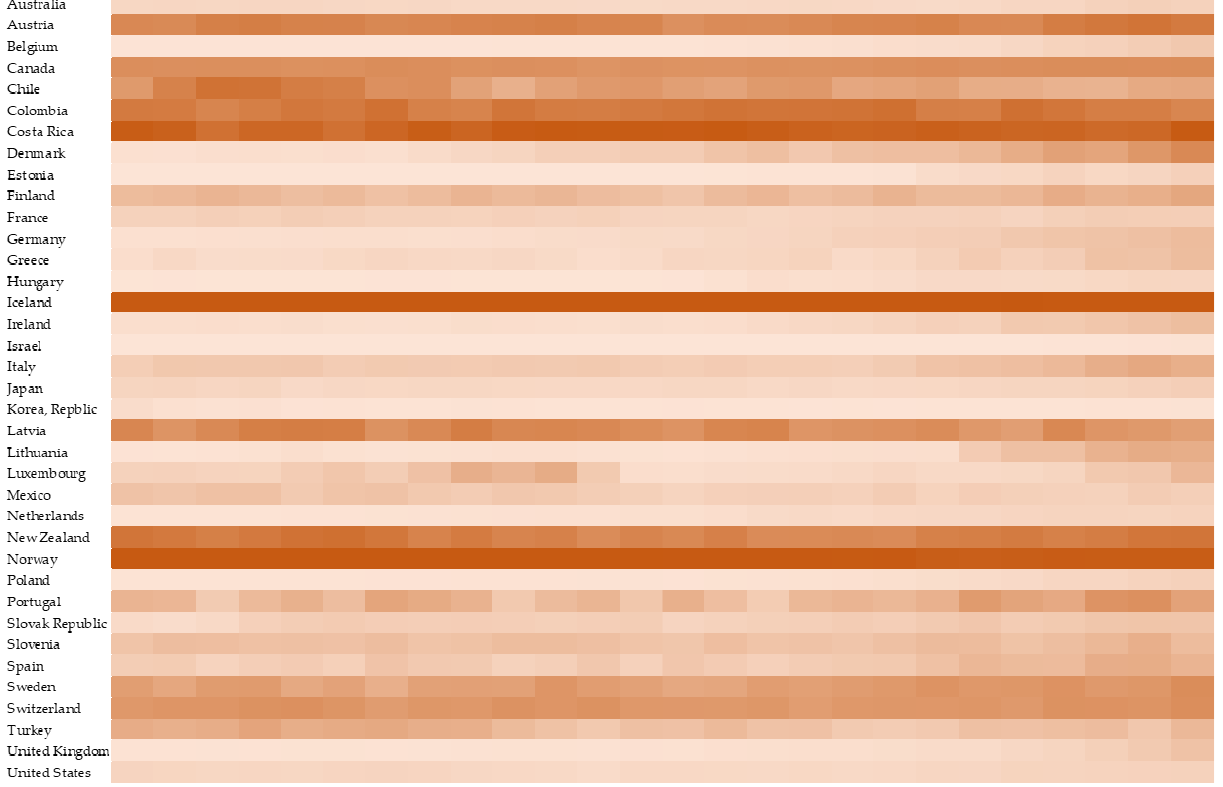
Figure 2. The heat map of REO for 37 OECD countries.